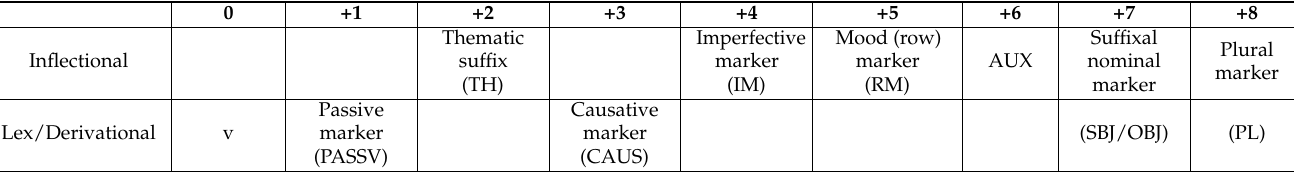
Table 2. Suffixal domain of Georgian